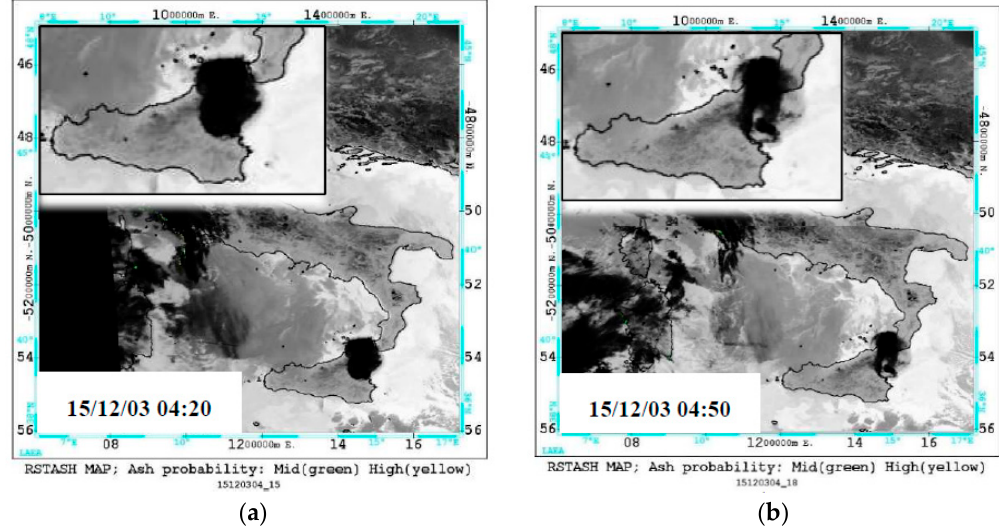
Figure 4. RST ASH maps from AVHRR data of December 3: ( a ) 04:20 UTC; ( b ) 04:50 UTC .